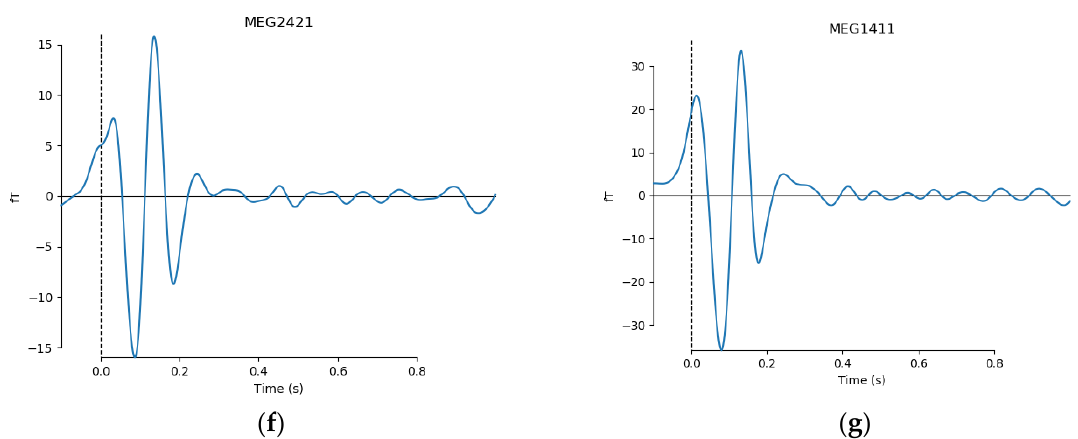
Figure 4. This figure shows MEG activity patterns from sensor level analysis. Here we see: ( a ) location of the selected channels; ( b ) IMF5 activities at channel 1621 (left supramarginal); ( c ) IMF5 activities at channel 2421 (right supramarginal); ( d ) IMF5 activities at channel 1411 (inferior frontal); ( e ) IMF6 activities at channel 1621; ( f ) IMF6 activities at channel 2421; ( g ) IMF5 activities at channel 1411.